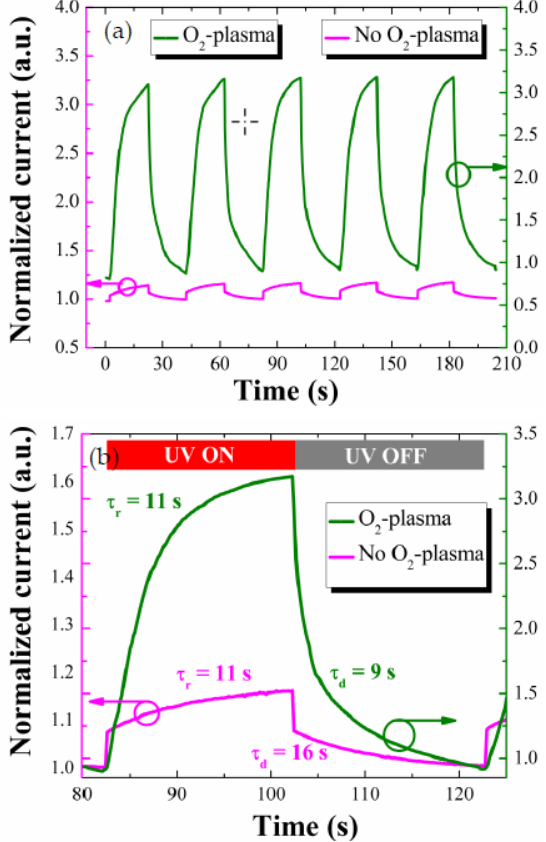
Figure 8. ( a ) Transient characteristics of p-Si/n-ZnO NRs heterojunction PDs grown on as-coated and O 2 -plasma-treated (for 9 min) SLs with ( b ) the expanded views of photoresponse in a single cycle.